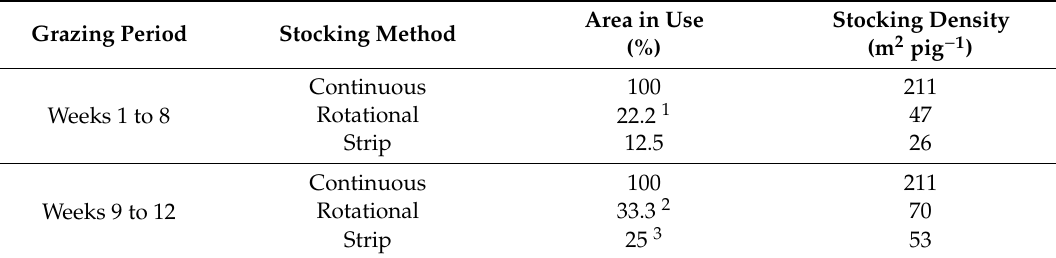
Table 1. Stocking methods under evaluation.